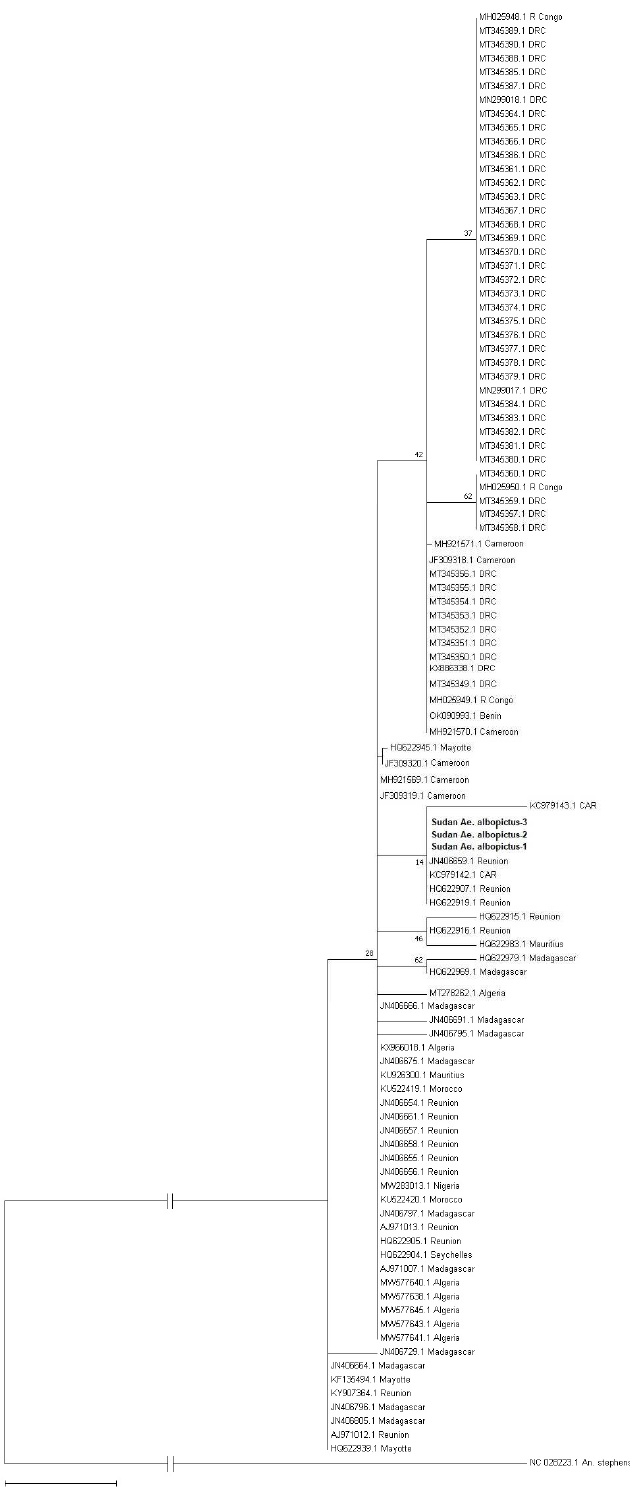
Figure 2. Maximum likelihood phylogenetic tree showing the relation between the Sudanese Ae. albopictus sequences and 103 African reference sequences. The Sudan Ae. albopictus sequences are highlighted in bold. The reference sequences along with their accession numbers and origin of the isolate are shown for each. DRC: Demogratic Republic of Congo, CAR: Central African Republic, R Congo: Republic of Congo. An. stephensi (Accession No. NC_028223.1) was used as an outgroup taxon. The branch to the outgroup was shortened by 0.020 substitutions per site. The bootstrap consensus tree inferred from 1000